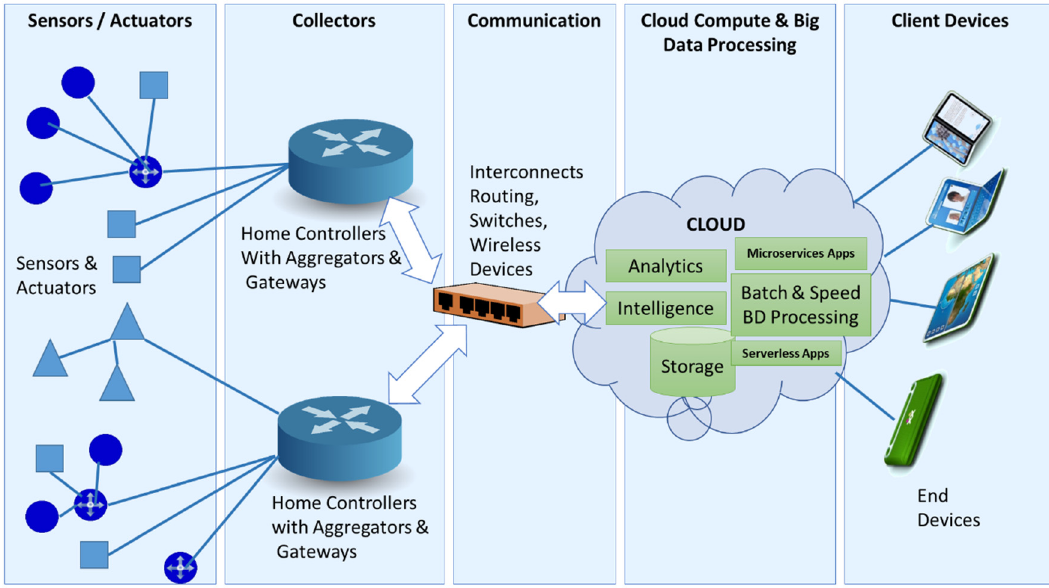
Figure 1. Generic IoT architecture with cloud and big data processing extensions.